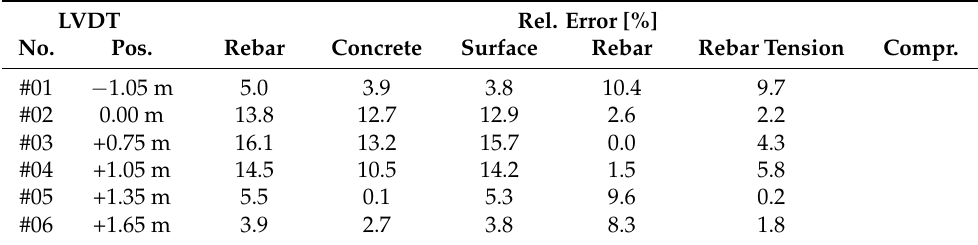
Table 3. Percentage errors of different installation techniques at the 300 kN load